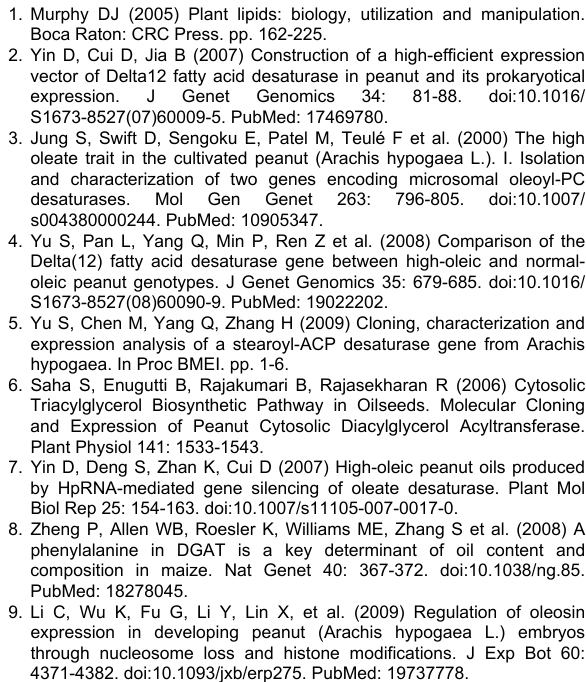
Table S6. Enzymes related to lipid metabolism in peanut seeds.